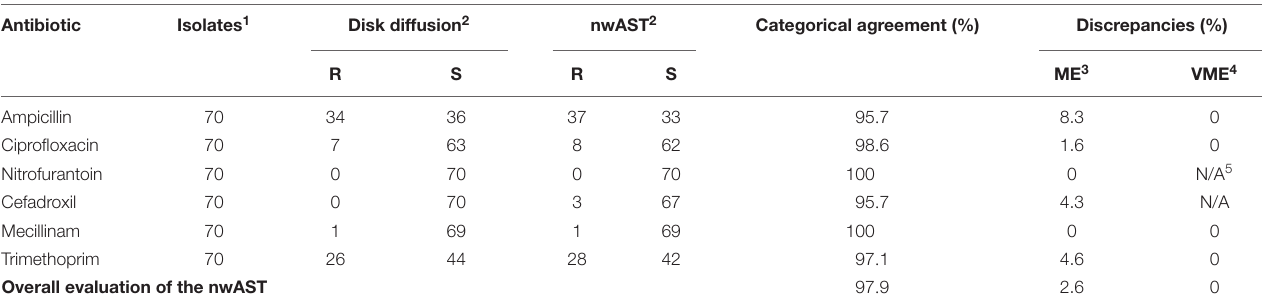
TABLE 1 | Clinical performance of the nwAST compared to the reference disk diffusion method.